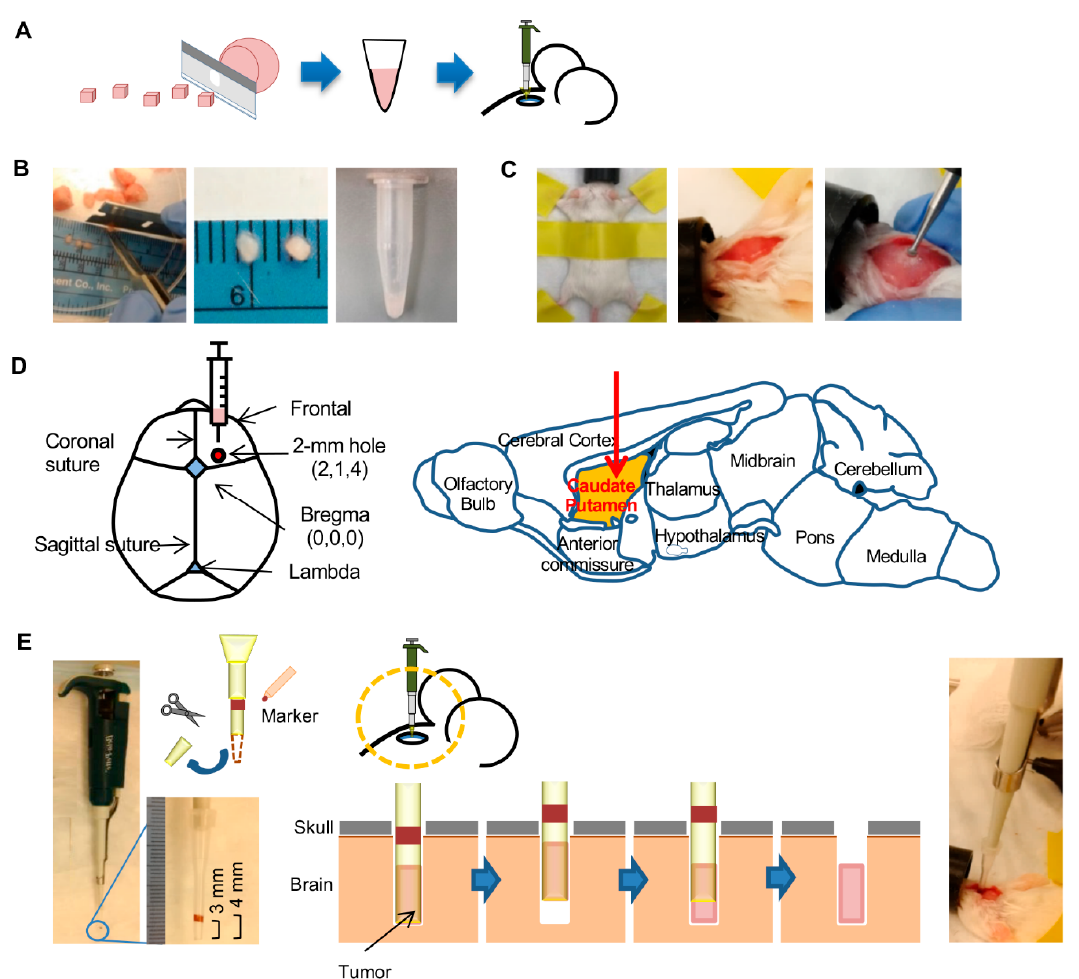
Figure 1. Method for implantation of tumor in mouse brain with the pipette method. ( A ) Workflow of the method involves mincing the tumor into ~1 mm 3 pieces with a blade. Size of the pieces is then further reduced by crushing the pieces in medium (2× volume) with a pipettor tip before injection of the preparation into mouse brain. ( B ) Photographs shows mincing of a tumor, some minced tumor pieces (ruler markings are in mm), and the injection-ready tumor preparation after crushing of the pieces with a pipette tip. ( C ) Preparation of mouse for tumor injection. An anesthetized mouse is secured in the prone position with tape. The crown of the head is shaved, and a 10-mm incision is made along the midline of the skull. A burr hole of 2 mm width is then made 2 mm lateral and 1 mm anterior to the bregma with a micro drill. ( D ) Coordinates for tumor injection are depicted on anatomic maps of mouse skull and brain. The 2-mm wide burr hole is at X, Y, and Z coordinates of 2 mm, 1 mm, and 4 mm with respect to the bregma. Tumor preparation is injected in the caudate putamen of brain. ( E ) Method of injection of the tumor preparation. The distal 1 cm of a 10-µL pipette tip is cut off with scissors, and a 1-mm wide marking is made on the tip at 3 mm distance from the tip’s opening. Tumor preparation (3 µL) is picked up with the tip attached to a pipette (photograph on left). The tip is then placed through the burr hole (photograph on right) to a depth of 4 mm. After withdrawing the tip by 1 mm, the tumor preparation is ejected by pushing the pipette plunger. The tip is then completely withdrawn, and the burr hole is sealed with bone wax and the scalp is sutured.